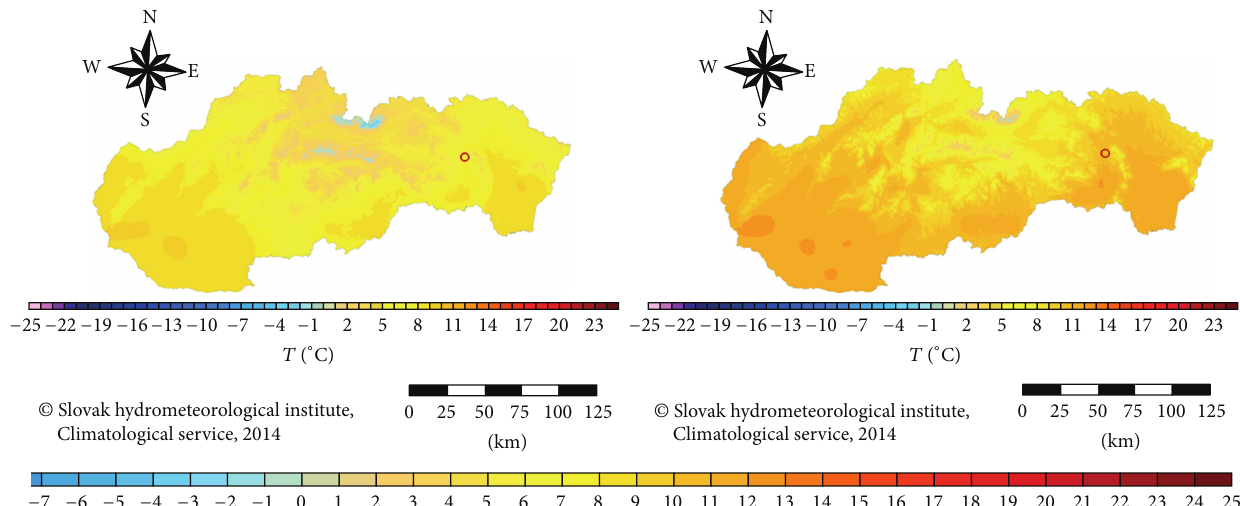
Figure 15: The average monthly air temperature in March/April 2014 [42] (according to the Slovak Hydrometeorological Institute).